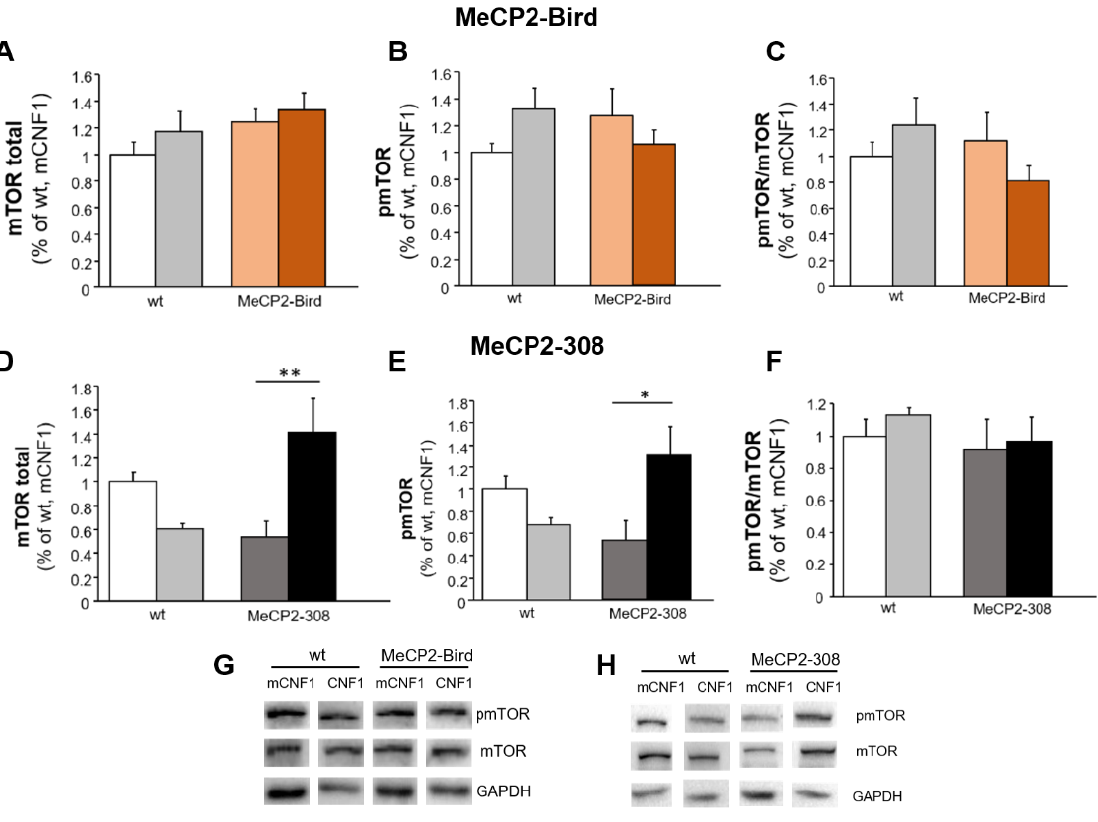
Figure 4. CNF1 treatment activates mTOR in the hippocampus of MeCP2-308 mice, but not in the MeCP2-Bird model. Total and phosphorylated (active) mTOR levels were evaluated by the means of Western blot analyses in hippocampi dissected from the brains of MeCP2-Bird, MeCP2-308 mice, and wild type (wt) littermates, treated with the recombinant (inactive, mCNF1) or active form of the bacterial toxin CNF1. ( A – C ) mTOR total or phosphorylated (pmTOR) levels and pmTOR/mTOR ratio did not significantly differ among groups in the MeCP2-Bird cohort. ( D – F ) CNF1 significantly increased both total and pmTOR levels in MeCP2-308 mice hippocampi but not the pmTOR/mTOR ratio . mTOR and pmTOR levels are normalised to total glyceraldehyde-3-phosphate dehydrogenase (GAPDH) contents and expressed as a proportion of those of wt, mCNF1 mice. ( G , H ) Immunoblots are examples from one animal of each experimental group. Mice for each condition were as follows: wt, mCNF1: 4 and 12; wt, CNF1: 4 and 12; MeCP2-Bird, mCNF1: 12; MeCP2-Bird, CNF1: 12; MeCP2-308, mCNF1: 4; MeCP2-308, CNF1: 4. Data are mean ± SEM. Statistical significance was assessed